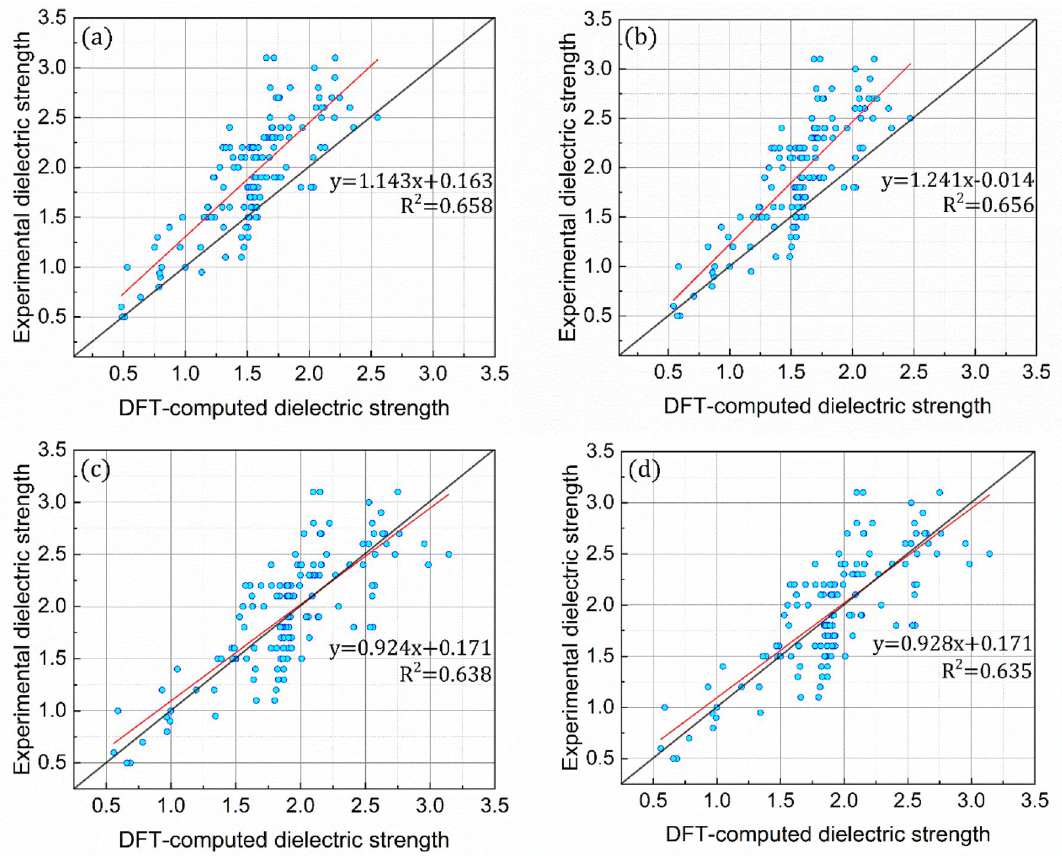
Figure 6. Validation of computational protocol with parameterized coefficients for dielectric strength. Comparisons between the equation-predicted and experimental dielectric strengths for all the organic compounds in Fig. S3 in the Supporting Information. The coefficients of the equations are parameterized for the equation-based prediction of the experimental values of either ( a ) 30, ( b ) 60, ( c ) 90 selected randomly